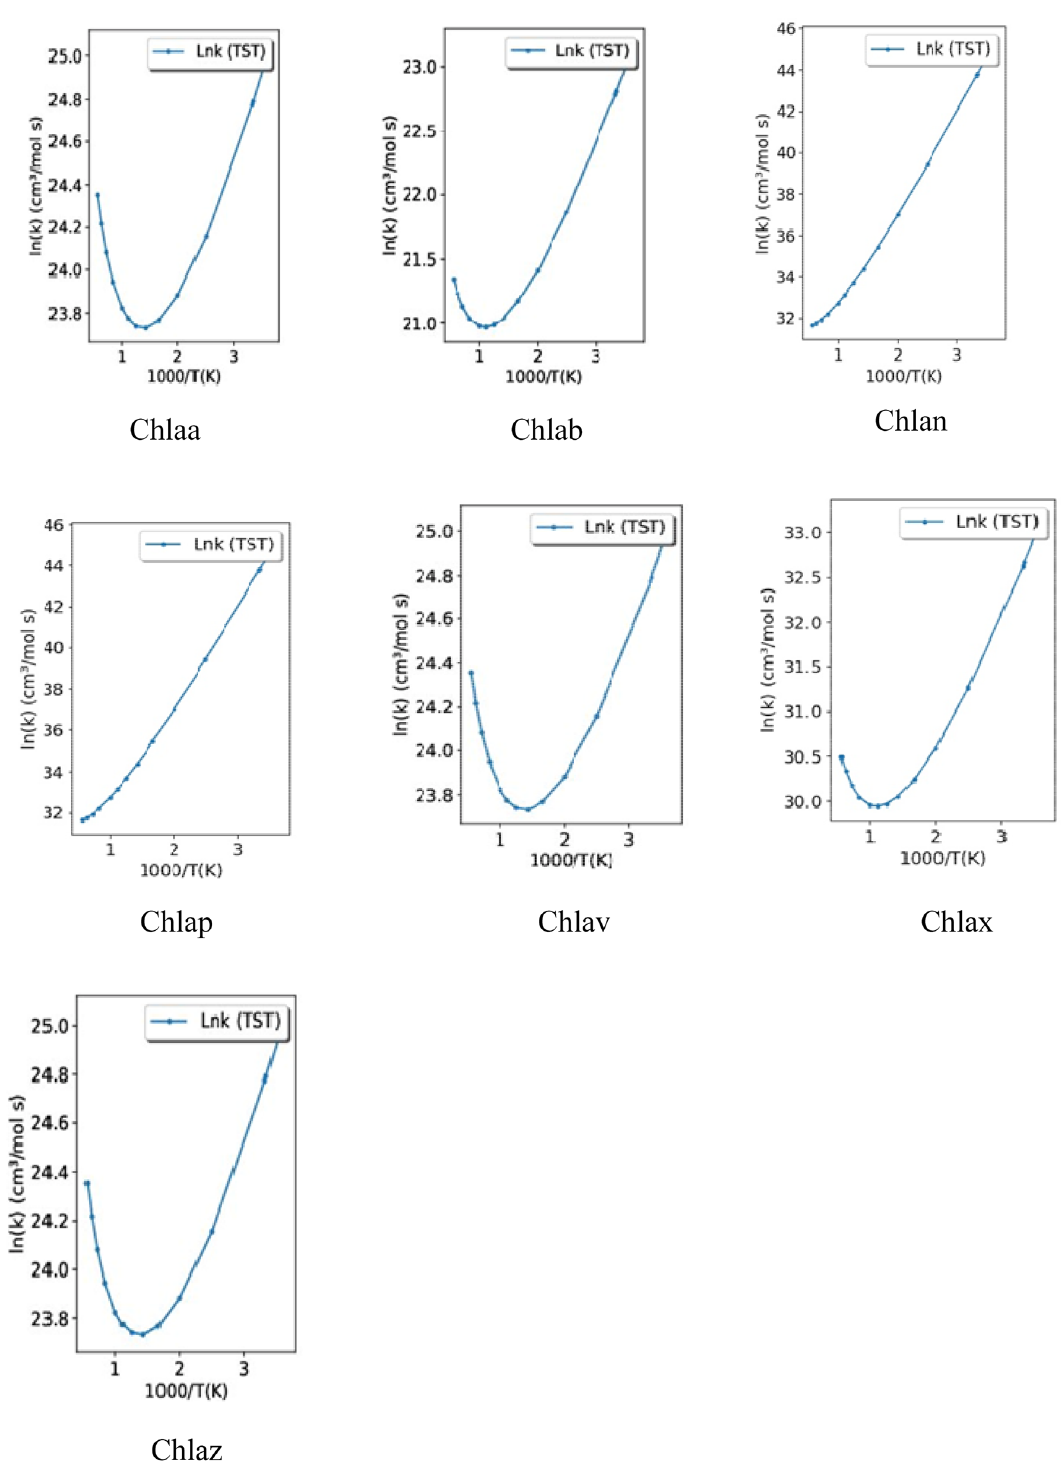
Figure 4. ( a ) Reaction rate constant graph for Chylla-carotenoid complexes (ln(k)) versus 1000/T(K). ( b ) Reaction rate constant graph for Chyllb-carotenoid complexes (ln(k)) versus